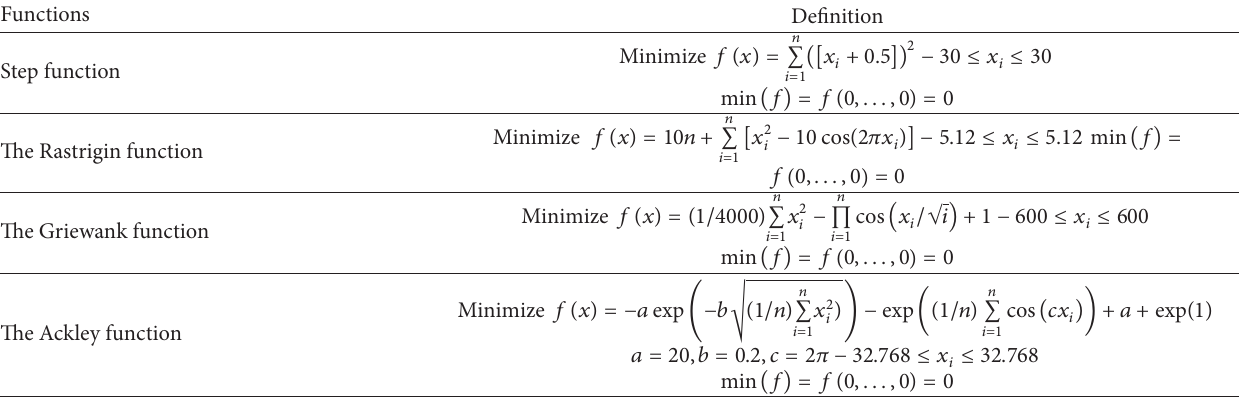
Table 4: Definitions and specification of 30D benchmark problems.